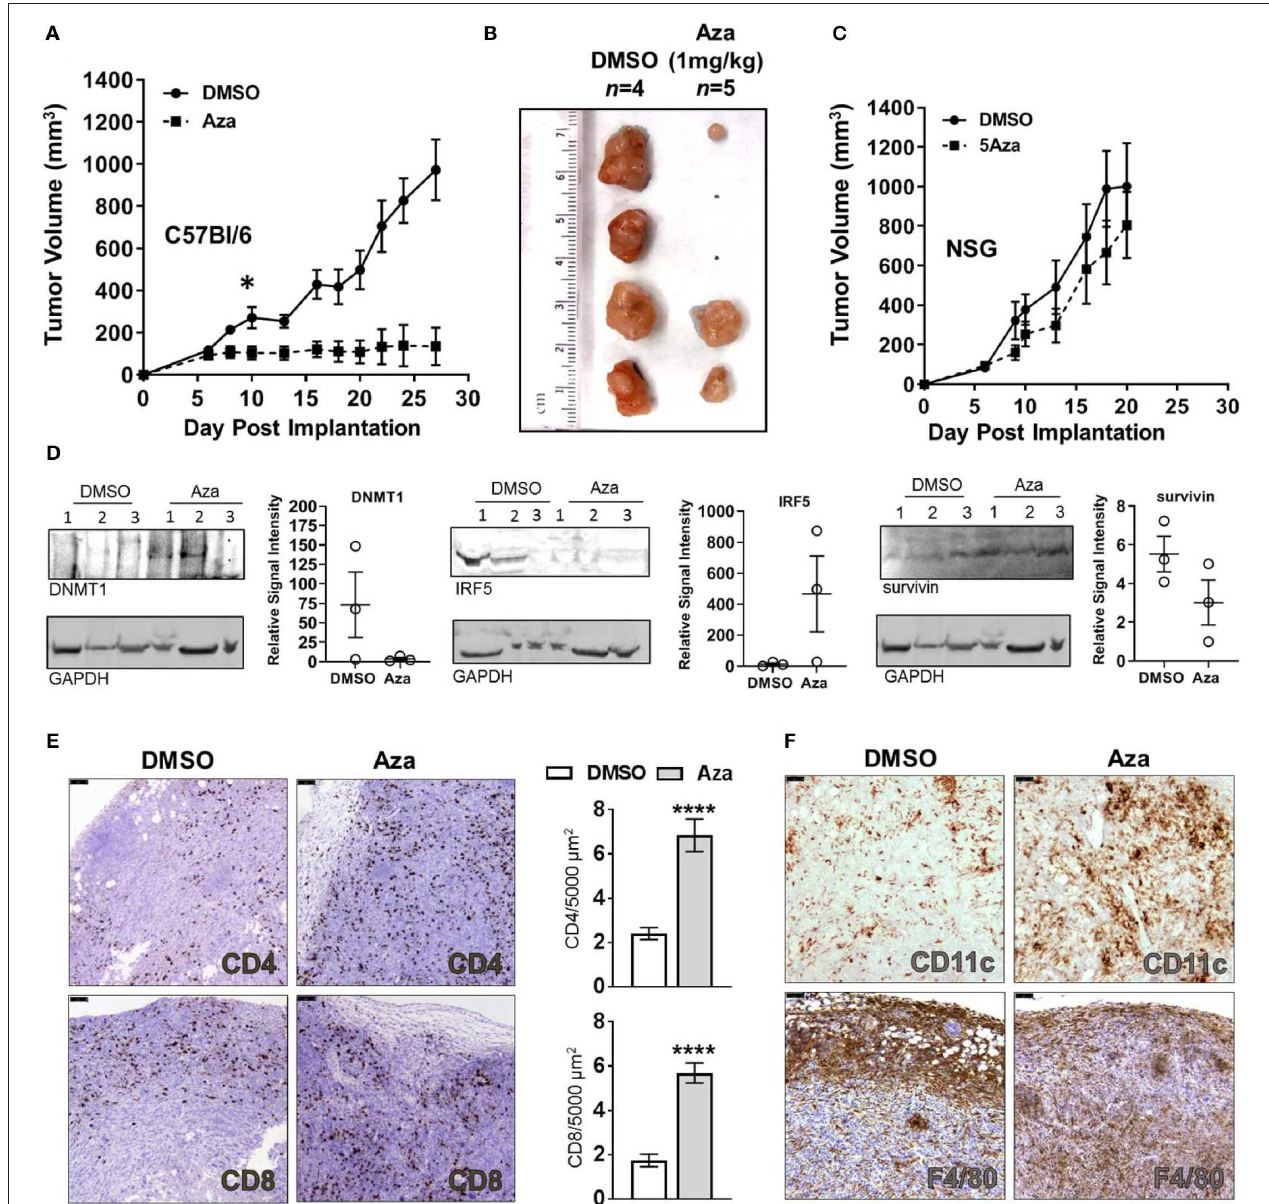
FIGURE 5 | Aza treatment controls PDAC tumor growth through an immune-dependent mechanism and induces significant infiltration by CD4 + and CD8 + T cells. (A) KPT277 tumor growth curves from immunocompetent C57Bl//6 mice treated with vehicle (DMSO) or 1 mg/kg 5-Azacytidine (Aza) once weekly. Measurements were taken three times weekly. Curves represent mean measurements for n = 4 mice in the DMSO group and n = 5 in Aza-treated group. (B) Tumors after removal from C57Bl/6 mice euthanized on Day 28. Ruler (cm) shows approximate tumor lengths. (C) KPT277 tumor growth curves from immunocompromised NSG mice treated with vehicle (DMSO) or 1 mg/kg 5-Azacytidine (Aza) once weekly. Measurements were taken three times weekly. Curves represent mean measurements for n = 5 mice in the DMSO group and n = 6 in Aza-treated group. Error bars represent standard error of the mean (SEM). * p < 0.05, t -test comparing data between groups on Day 10. (D) Western blots of tumor lysates ( n = 3 per group) from Day 8 Aza and DMSO-treated tumors (48h after first treatment) using anti-DNMT1, anti-IRF5, and anti-survivin antibodies. GAPDH is shown as a loading control. DNMT1 and survivin were assayed using the same blot. Relative quantifications of band intensity normalized to GAPDH are shown to the right of blots (individual values plotted, error bars = SEM). Increased frequency and infiltration of (E) CD4 + and CD8 + T cells, and (F) CD11c + and F4/80 + cells as determined by IHC in tumor tissue fixed 48h after initial dosing with DMSO or Aza. Scale bars = 75 µ m. Dab signal (brown) indicates CD4 + , CD8 + , CD11c + , or F4/80 + staining. Nuclei were counterstained with hematoxylin. Positive-staining cells were enumerated for 30–40 fields approximating the entire tumor ( n = 2 tumors DMSO, n = 3 tumors Aza) and are presented as cells per 5,000 µ m 2 tumor area (bar graph). Error bars represent SEM. **** p < 0.0001, Mann-Whitney